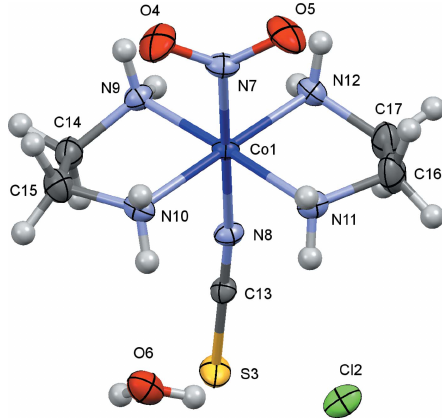
Figure 2 The molecular structure of (II), showing displacement ellipsoids at the 30% probability